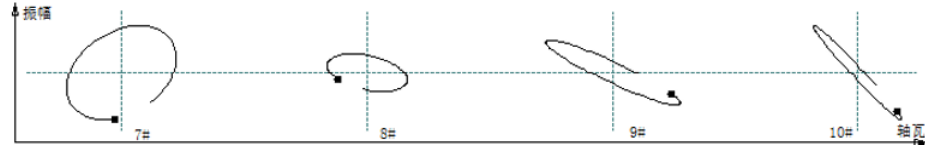
Fig. 2. Hologram of excitation